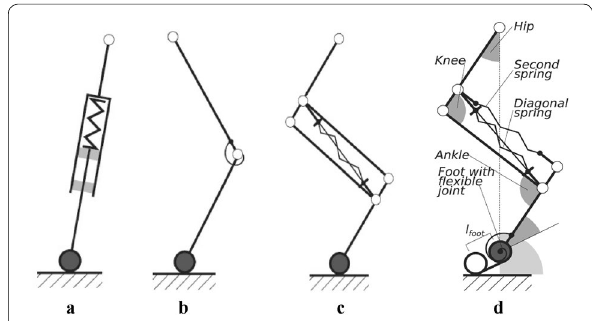
Figure 10 Possible designs for compliant legs [40]: a telescopic-prismatic; b two-segment; c three-segment; d